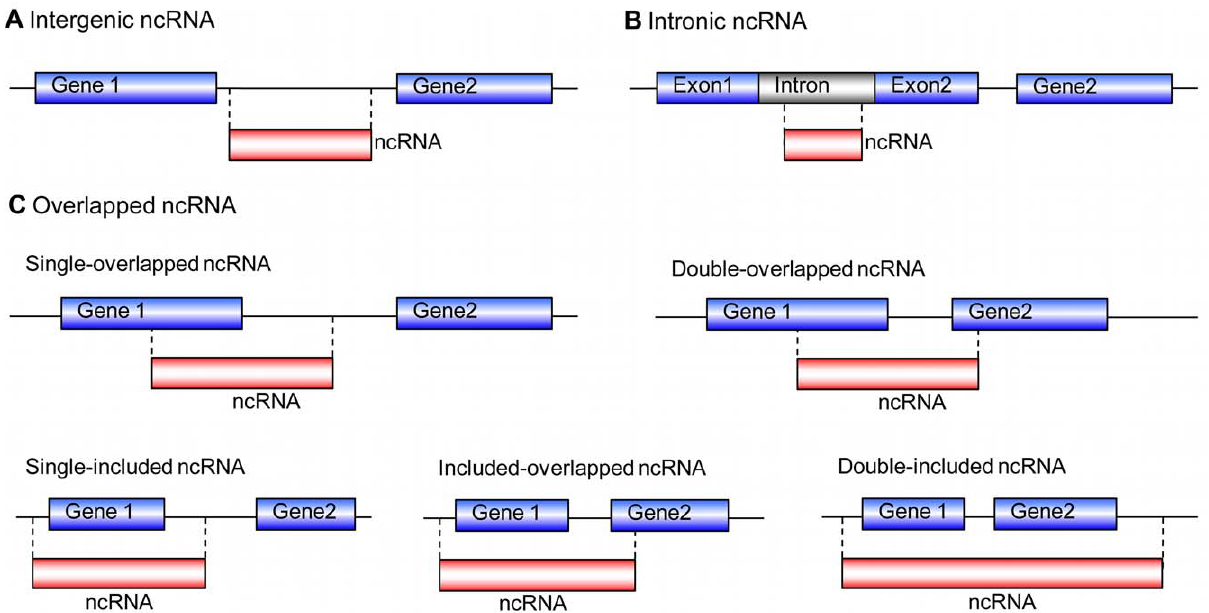
Figure 4. Classification of ncRNAs in relation to protein-coding genes. (A) The entire EST is transcribed from an intergenic region, regardless of the transcription orientation. (B) The entire EST is transcribed from an intron, regardless of the transcription orientation. (C) Single-overlapped ncRNA: EST partially overlapped with a gene; Double-overlapped ncRNA: Both ends of the EST overlapped with two genes and spanned an intergenic region; Single-included ncRNA: The gene was fully included inside the EST; Included-overlapped ncRNA: One gene was fully included within the ncRNA, and the ncRNA spanned the intergenic region and overlapped with a neighbour gene; Double-included ncRNA: More than one genes were fully included within the EST.